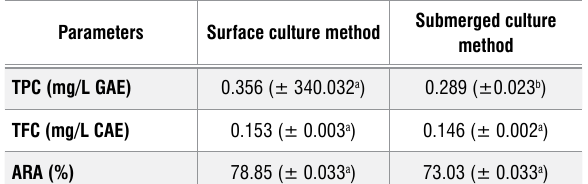
Chemical characteristics of marula vinegars produced using surface and submerged culture methods with the inoculation technique parameters